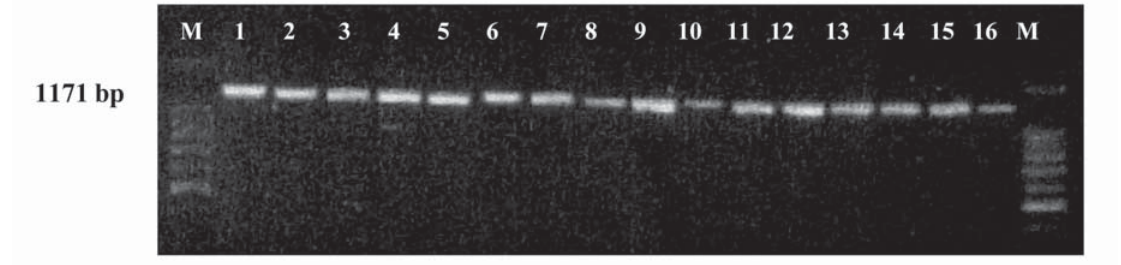
Fig. 3. Electrophoresis on 1% agarose gel showing the result of the PCR amplification of the Bc-hch gene by the 262/ 520L primer; M, 100 bp